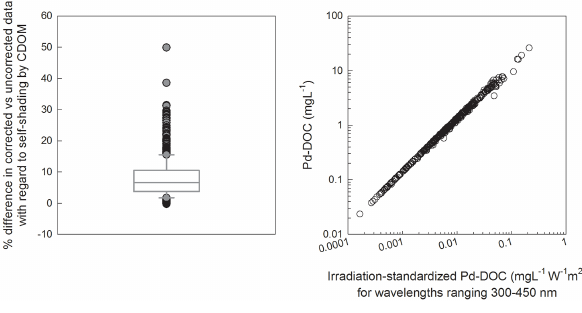
Figure A2. Comparing uncorrected vs. light-standardized concen- trations of PDOC based on CDOM self-shading for wavelengths ranging